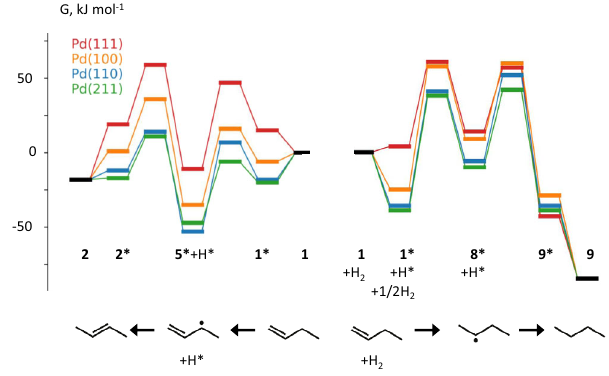
Fig. 5 Calculated free energy pro fi les of the transformations of 1-butene, 1: isomerization (to the left) vs. hydrogenation (to the right). Lowest energy pathways only. For easy comparability of isomerization and hydrogenation, we start at the center with 1-butene 1 in the gas phase that adsorbs on Pd(111) (red), Pd(100) (orange), Pd(110) (blue), and Pd(211) (green). The isomerization of 1 to 2-butene, 2 , starts with a dehydrogenation of 1 to 1-buten-3-yl 5 and co-adsorbed H*. As reference of this transformation, we use the free energy value of 1-butene 1 in the gas phase at 373 K, 100 kPa; the partial pressure values were P 1-butene = 5 mbar and P H2 = 3.7 mbar with a standard surface concentration of θ ° = 0.5. For the hydrogenation of 1 to butane 9 , we use 1-butene 1 and H 2 as free energy reference. This transformation starts with a hydrogenation to 2-butyl 8 ; see Fig. 1. In the fi nal step of each reaction path, the product, 2-butene 2 or butane 9 , respectively, is desorbed into the gas phase. The free energy of 9* is shifted, by − 40 kJ mol − 1 from the DFT model results. This empirical correction re fl ects the challenging nature of modeling such processes by the DFT methodology applied; for details, see the text. This correction is inspired by experimental data on the typical entropy loss during the adsorption, from the gas, of saturated hydrocarbons on late transition metal